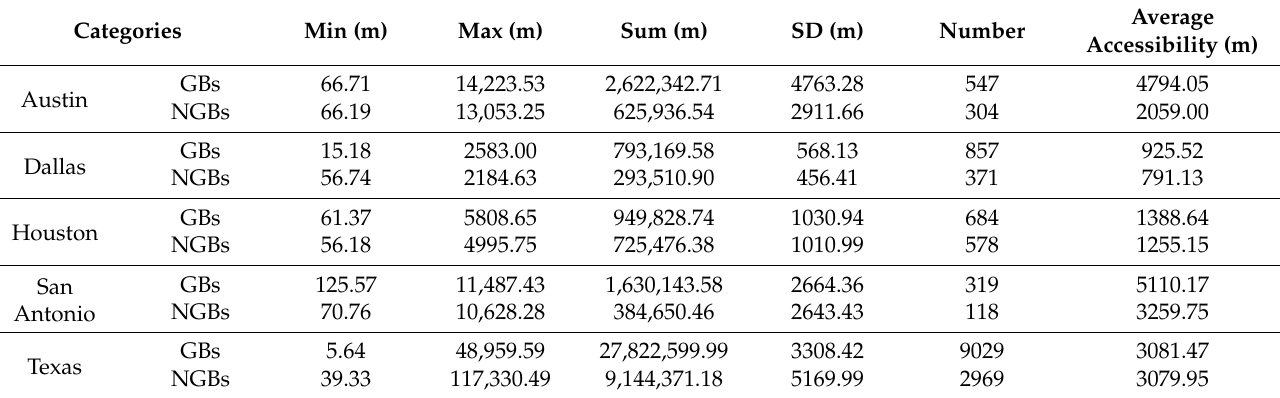
Table 3. Accessibility of green spaces for green and nongreen buildings.